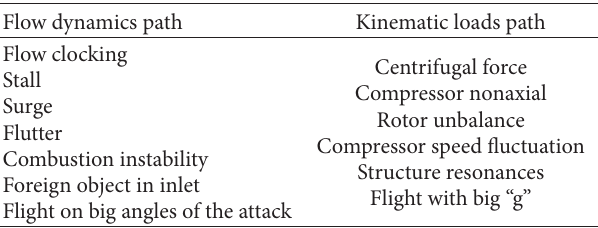
Table 1: Endurance threats of real blades permanence (“live”) according to the theory of five elements